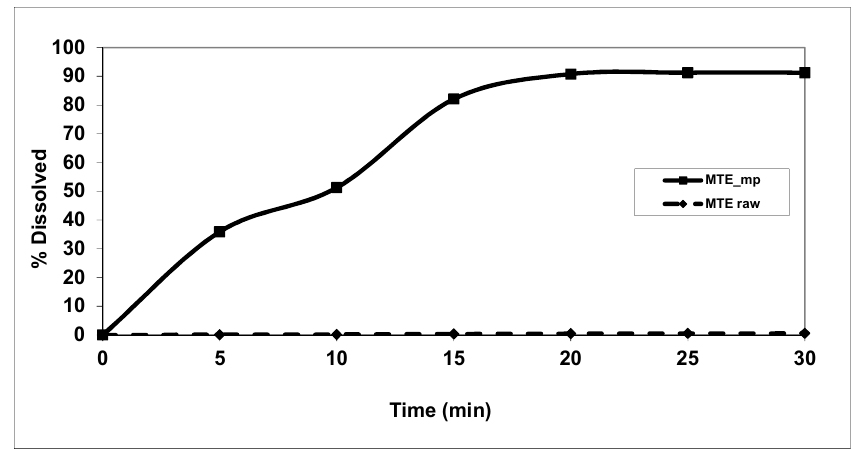
Figure 6. In vitro dissolution profiles of MTE_mp (black line) and MTE extract raw (dotted line) (standard deviation data <1%).